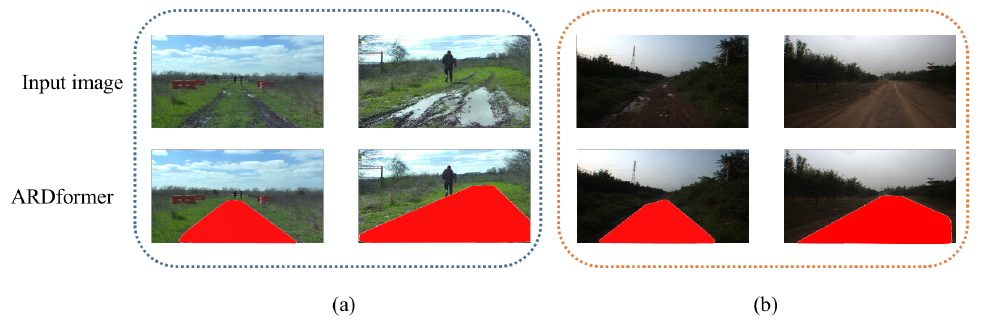
Figure 7. Visualization result of ARDformer in other agroforestry environment. ( a ) RELLIS-3Ddataset, ( b ) real agroforestry